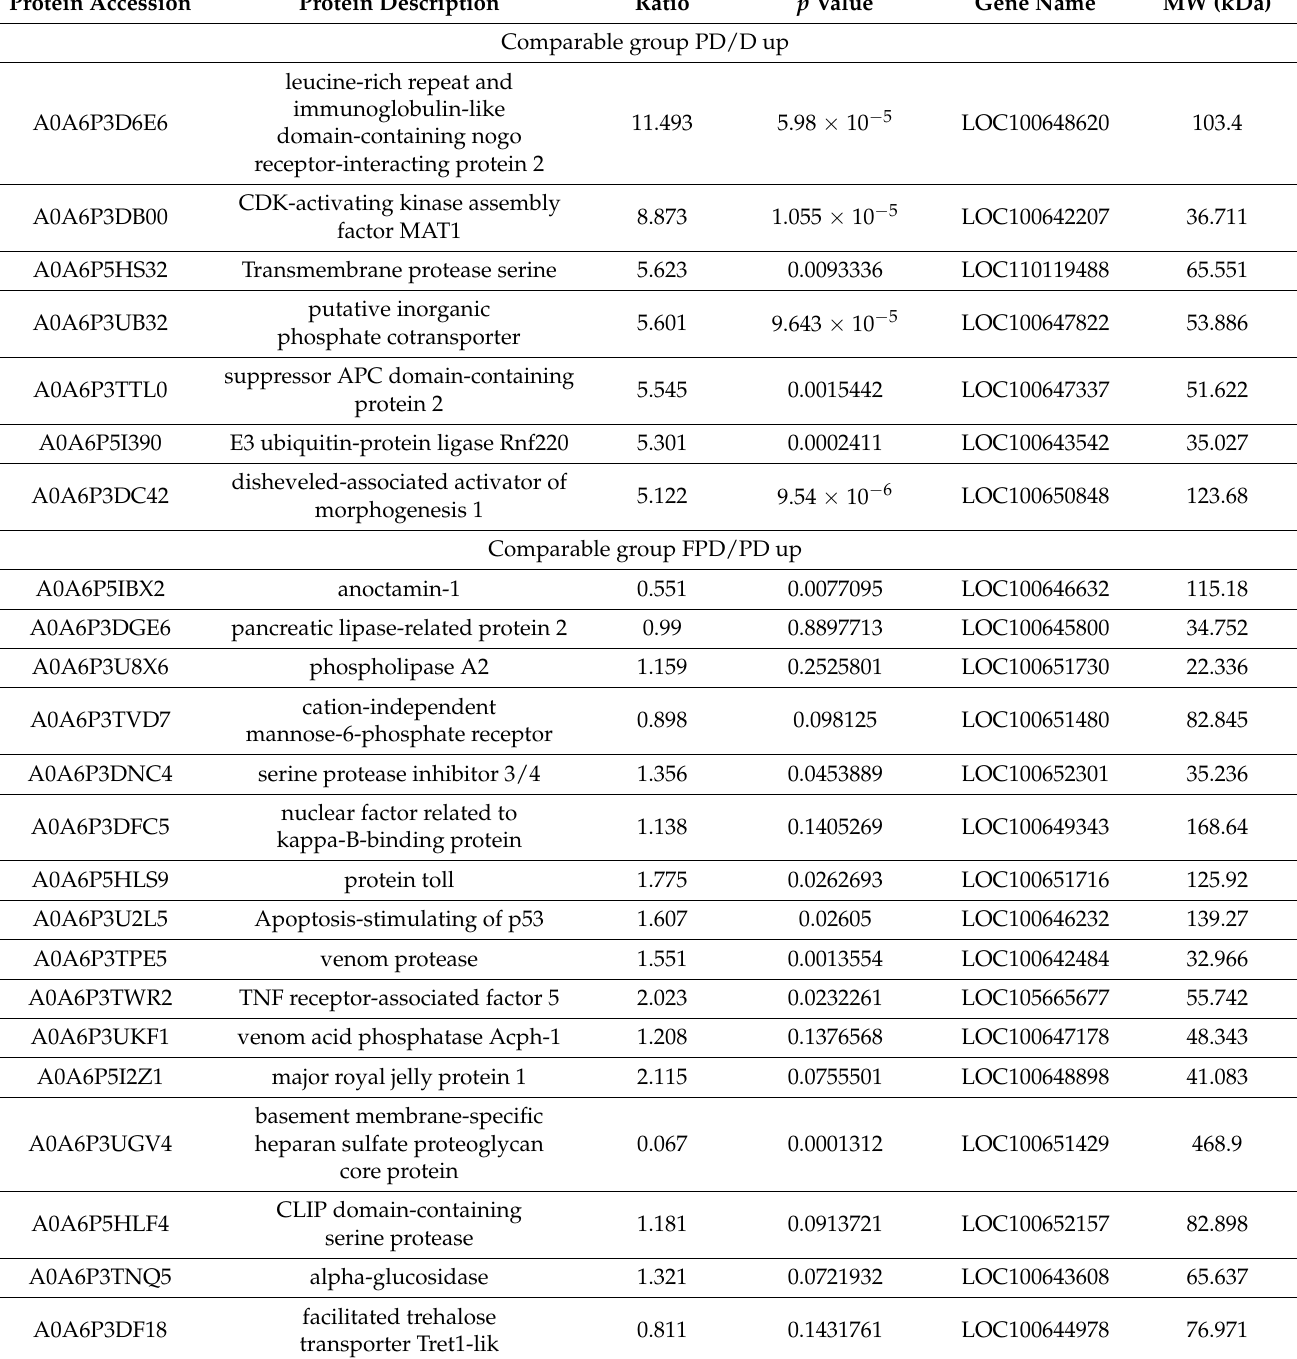
Table 1. The upregulated DEPs in PD/D and FPD/PD with fold changes higher than 5.